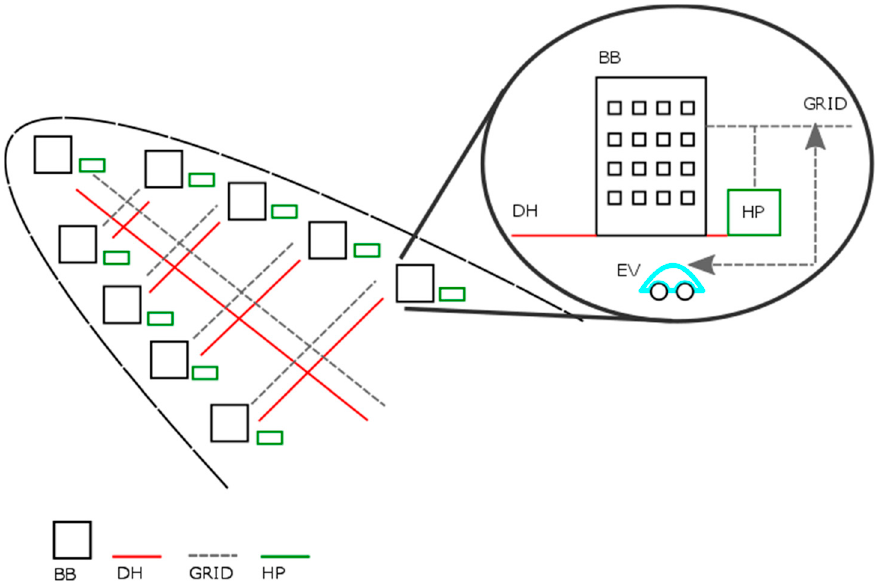
Figure 2. Conceptual illustration of the case study within the vehicle-to-grid (V2G) scenario. HP: heat pump; EV: electric vehicle.